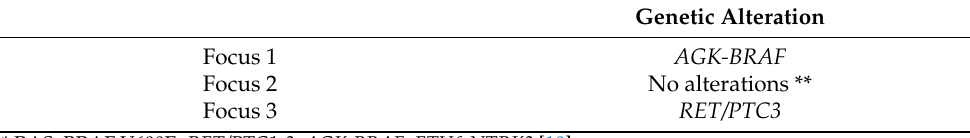
Table 1. Genetic alterations observed in each focus of the pediatric PTC assessed in this